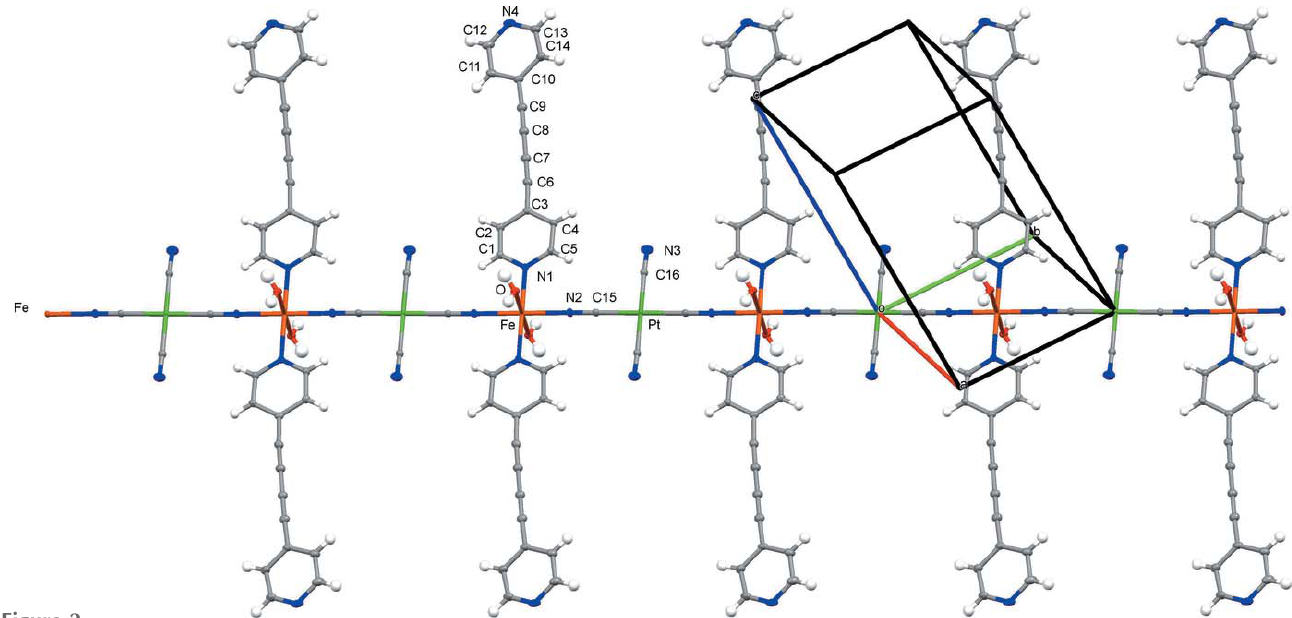
Figure 2 A fragment of the endless polymeric chain of the title compound with the atom-numbering scheme.